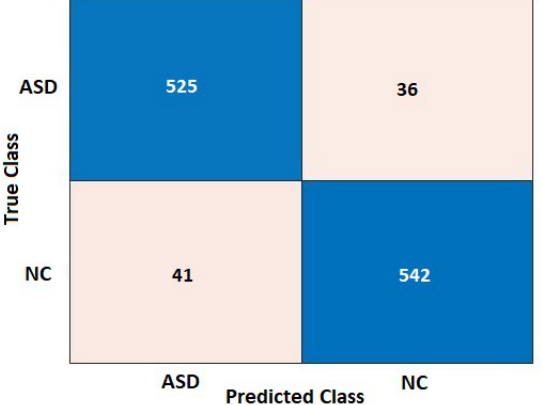
Figure 9. Confusion matrix for classification of PWC images of ASD and NC using the testing dataset.